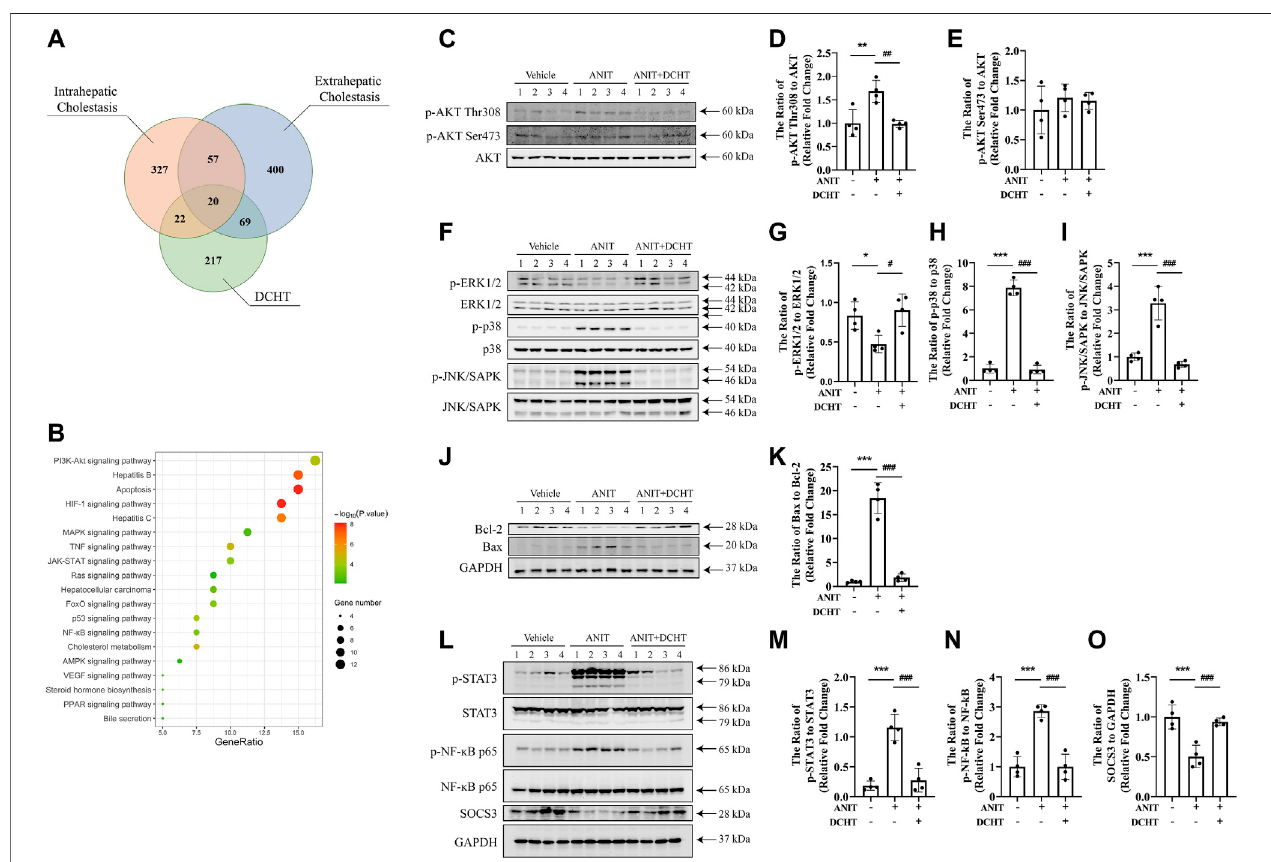
FIGURE4| DCHTregulatesthesignalingaxesofMAPK/NF- ĸ B/STAT3inANIT-inducedcholestaticliverinjury invivo . (A) VenndiagramofputativetargetsinDCHT and cholestasis. The orange circle, blue circle and green circle indicate 426 putative targets involved in intrahepatic cholestasis, 546 putative targets involved in extrahepaticcholestasisand328putativetargetsinvolvedinDCHTtreatment,respectively. (B) KEGGpathwayenrichmentanalysisoftheDCHTtargetsfrom Figure5A . (C – O) Protein levels of p-AKT Thr308, p-AKT Ser473, AKT, p-ERK1/2, ERK, p-p38, p38, p-JNK/SAPK, JNK/SAPK, Bcl-2, Bax, p-STAT3, STAT3, p-NF- ĸ B p65, NF- ĸ B p65, SOCS3 and GAPDH were measured by immunoblot after DCHT treatment (1.875 g/kg). The data are expressed as the ratios of p-AKT Thr308 to AKT (D) , p-AKT Ser473 to AKT (E), p-ERK1/2 to ERK (G) , p-p38 to p38 (H) , p-JNK/SAPK to JNK/SAPK (I) , Bax to Bcl-2 (K) , p-STAT3 to STAT3 (M) , p-NF- ĸ B p65 to NF- ĸ B p65 (N) ,SOCS3toGAPDH (O) .Dataareshownasmeans±S.E.M.;* p < 0.05,** p < 0.01,*** p < 0.001comparedwithcontrolgroup; # p < 0.05, ## p < 0.01, ### p < 0.001 compared with ANIT treatment group, n =